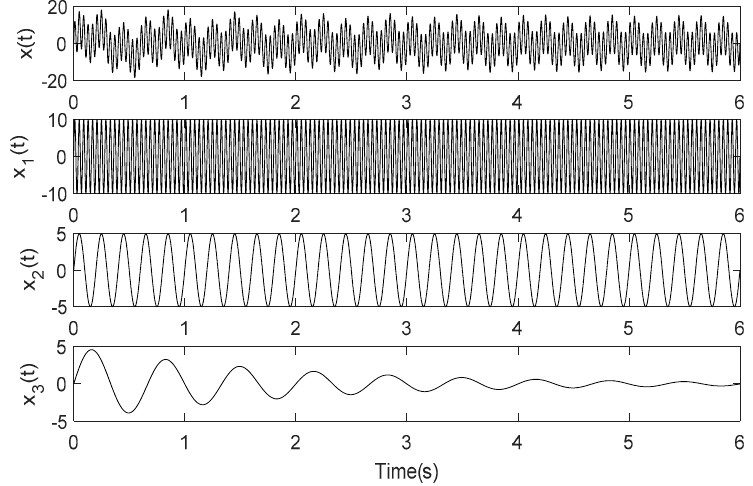
Figure 6. Time-domain waveform of the simulation signal x ( t ) and its components.